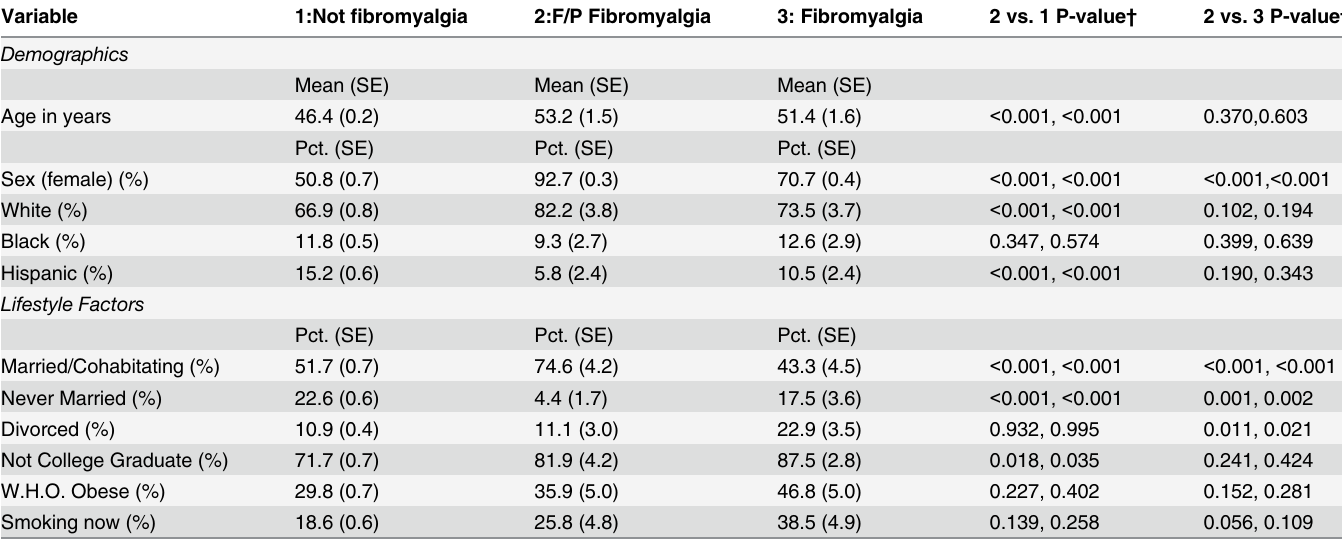
Table 4. Comparison of demographics and allied Factors between persons without fibromyalgia, F/P fibromyalgia, and those that meet NHIS fibro- myalgia